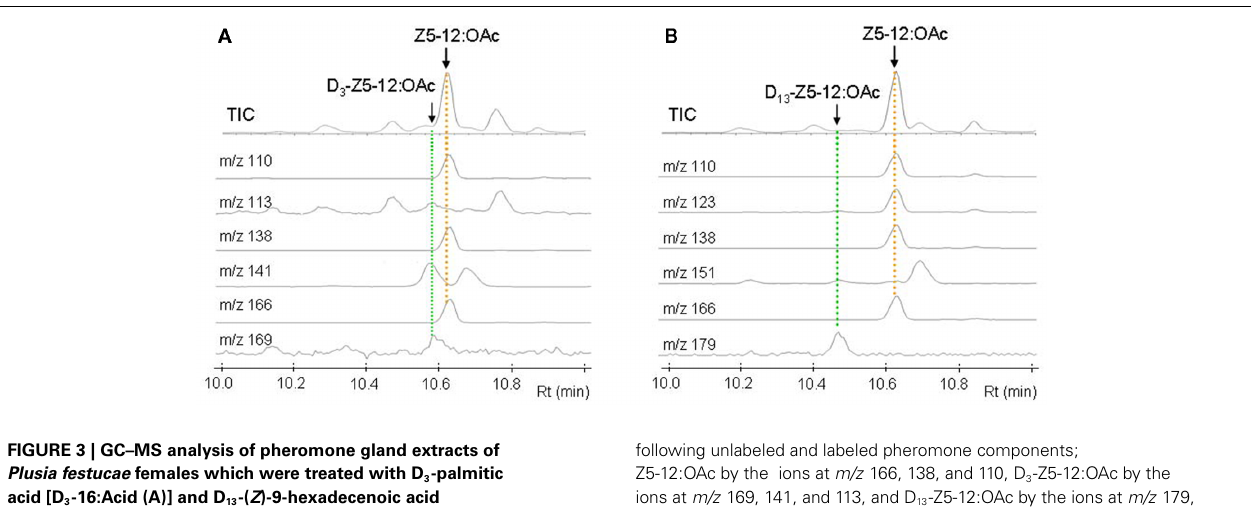
FIGURE 3 | GC–MS analysis of pheromone gland extracts of Plusia festucae females which were treated with D 3 -palmitic acid [D 3 -16:Acid (A)] and D 13 -( Z )-9-hexadecenoic acid [D 13 -Z9-16:Acid (B)]. The mass chromatograms indicated the